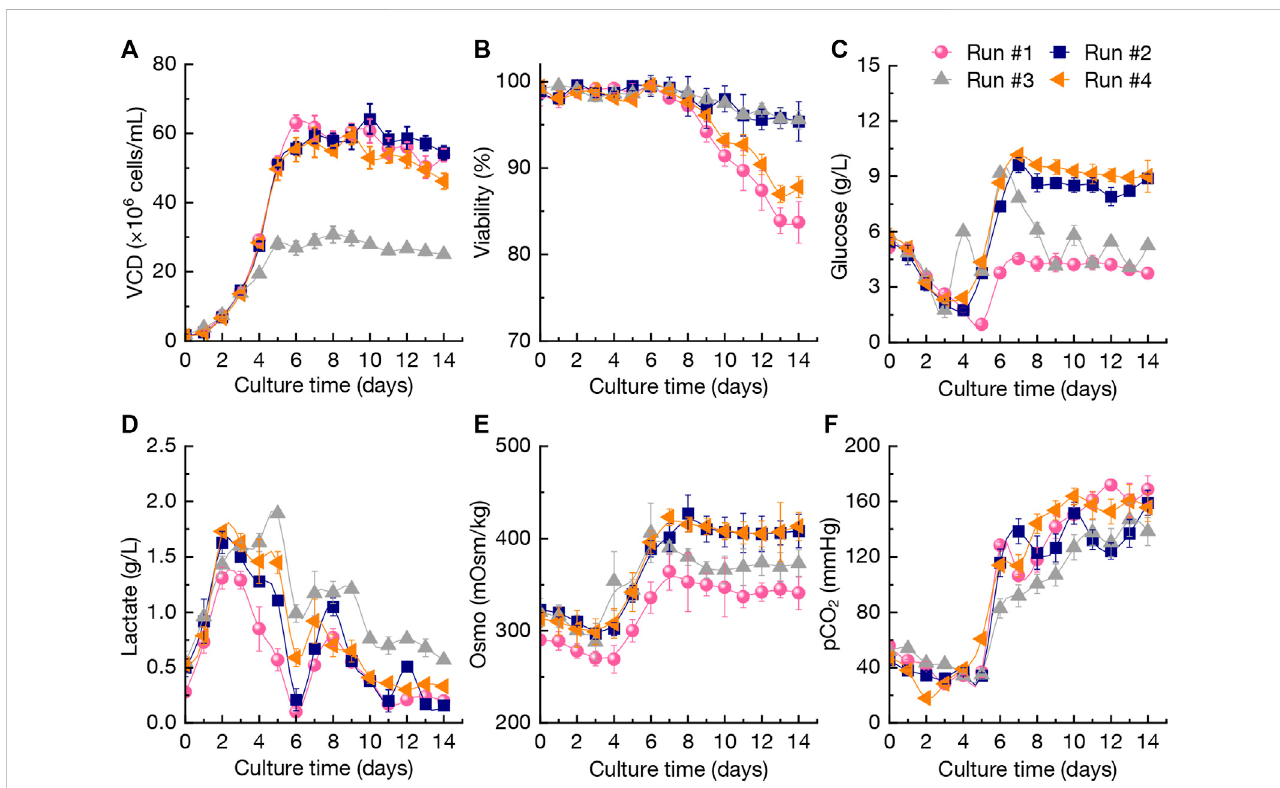
Changing pro fi les of viable cell density (VCD) (A) , viability (B) , glucose concentration (C) , lactate concentration (D) , osmolality (Osmo) (E) , and pCO 2 (F) during perfusion cultures using different media in 3-L bioreactor. The error bars indicate the standard deviations (SD) of three independent